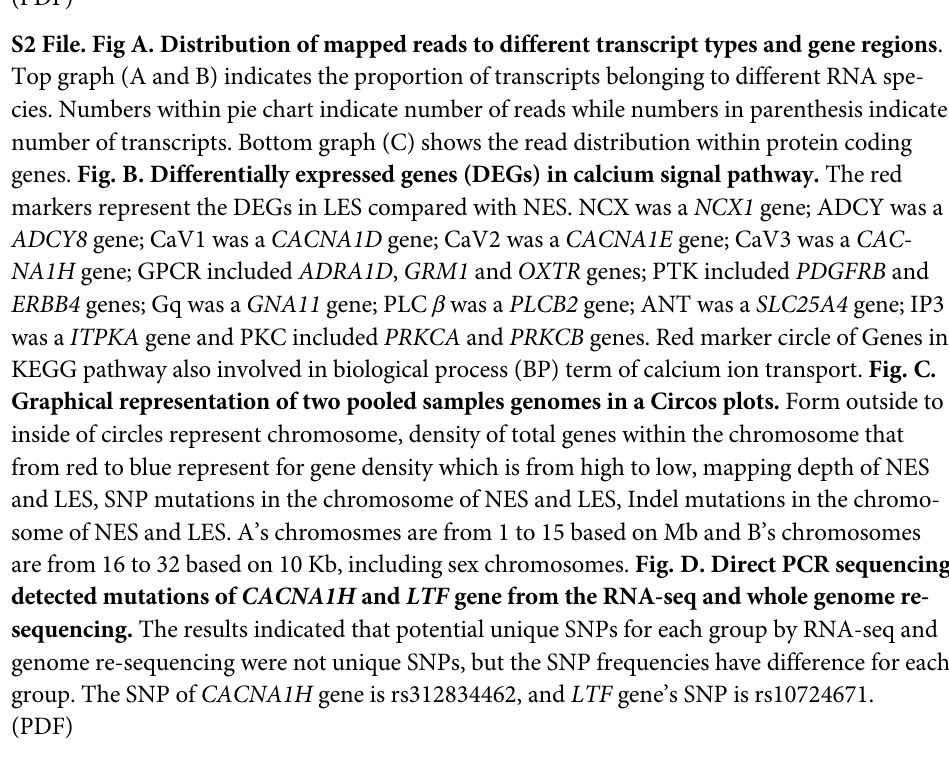
S1 File. Table A. Primers used for qPCR of calcium signaling pathway genes. Table B. Primers used for direct PCR sequencing of the potential group-specific mutations. Table C. RNA se- quencing of eggshell quality in Rhode Island White hens. Table D. Whole genome re-sequenc- ing of eggshell quality in Rhode Island White hen. Table E. Frameshift mutations in the differentially expressed genes in KEGG